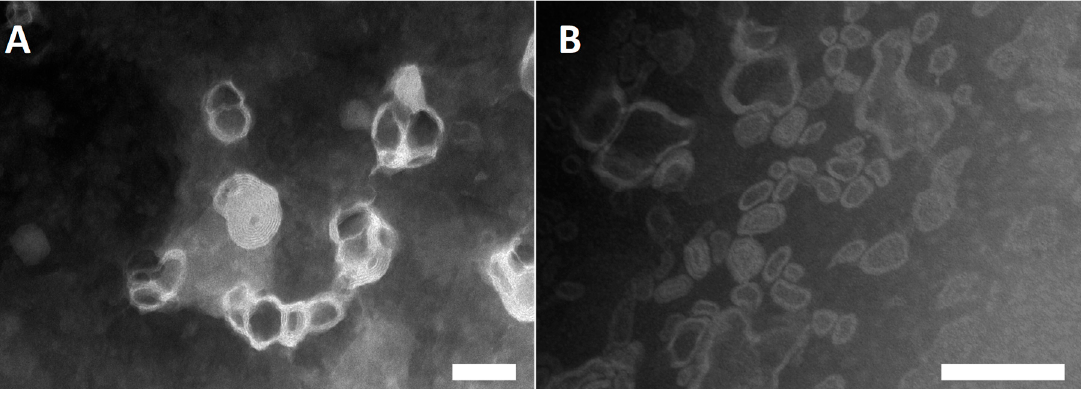
Figure 1. Transmission electron microscopy (TEM) images of pompia essential oil liposomes ( A ) and citral liposomes ( B ). Bars correspond to 100 nm.